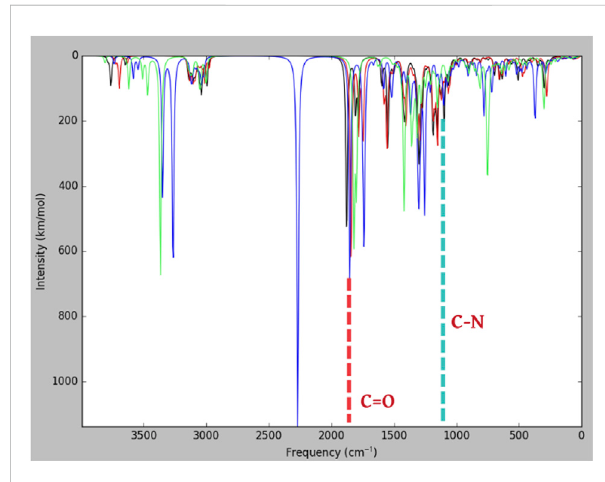
FIGURE 6 Predicted IR spectra (B3LYP/6-31+G*) for meropenem and its